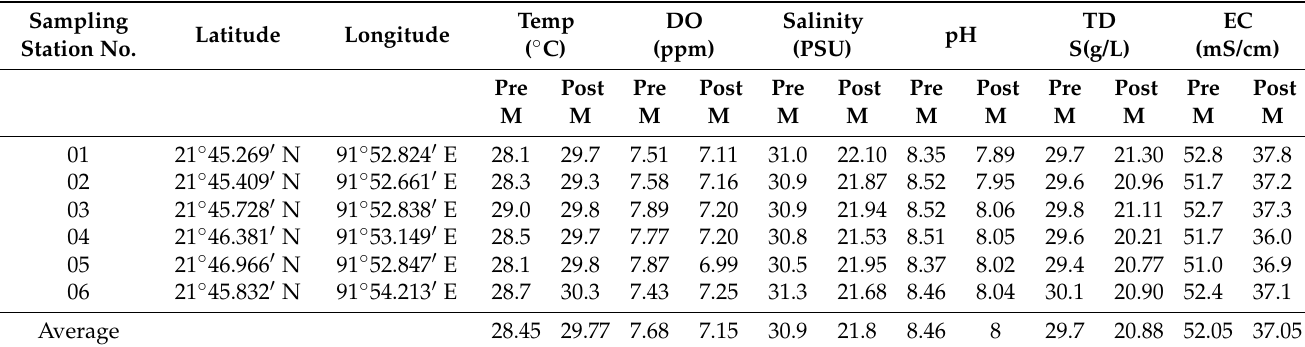
Table 1. Physicochemical parameters of Kutubdia Channel water samples during pre-monsoon (Pre M) and post-monsoon (Post M).